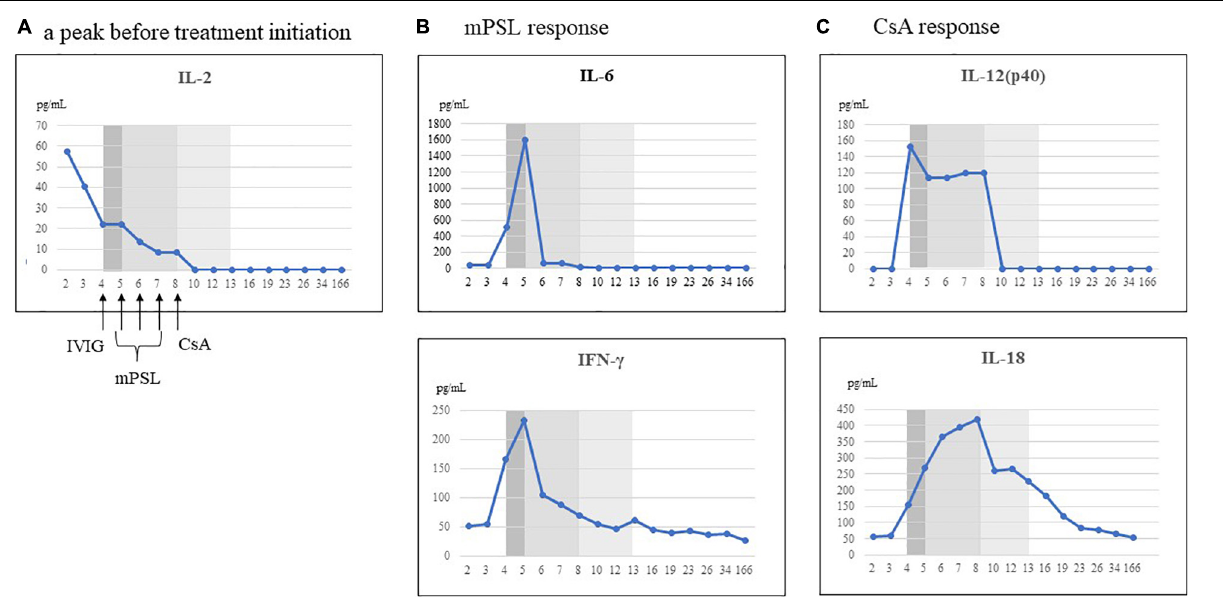
FIGURE 2 | Representative cytokines that responded to each treatment. We classified the treatment response when the cytokine decreased by 50% from the peak levels, referenced to the day 166 levels for each cytokine. (A) Cytokine decreased prior to initiation of treatment. (B) Cytokines that responded to methylprednisolone (mPSL) treatment. (C) Cytokines that responded to ciclosporin A (CsA) treatment. IL, interleukin; IFN, interferon; IVIG, intravenous immunoglobulin